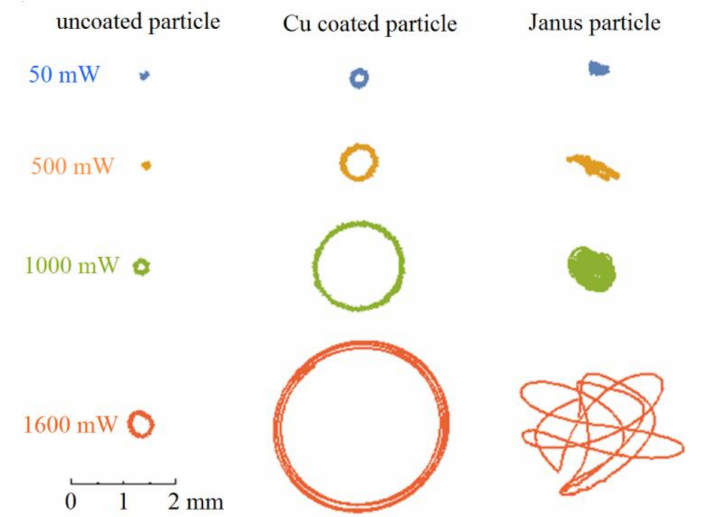
Figure 2. Trajectories of a particle during 5 s, levitating in the near-electrode region of a RF discharge under action of laser radiation with a power of 50, 500, 1000 and 1600 mW. Left row—uncoated particle; center row—Cu-coated particle; right row—Janus